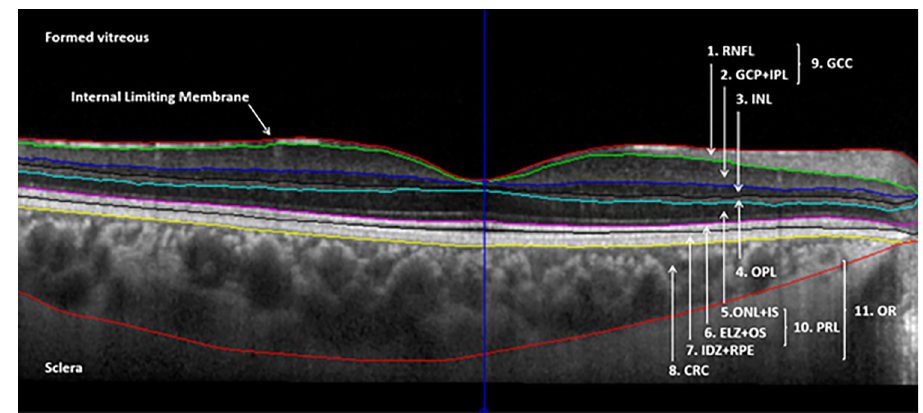
Fig 2. Segmented macular OCT image showing all segmented boundaries by the OCTRIMA 3D algorithm. The segmented retinal layers shown on the image are the following: retinal nerve fiber layer (RNFL), ganglion cell and inner plexiform layer complex (GCL+IPL), inner nuclear layer (INL), outer plexiform layer (OPL), complex layer containing the Henle fiber layer, outer nuclear layer, external limiting membrane and the myoid zone of the photoreceptors (ONL+IS), complex layer containing the ellipsoid zone and the outer segment of the photoreceptors (ELZ+OS), complex layer containing the interdigitation zone, retinal pigment epithelium and Bruch’s complex (IDZ +RPE) and choroid containing the choriocapillaris, Sattler’s layer and Haller’s layer as far as the choroidal-scleral juncture (CRC). Composite layers, such as the ganglion cell complex (GCC), photoreceptor layer (PRL) and outer retina (OR) are also shown in the